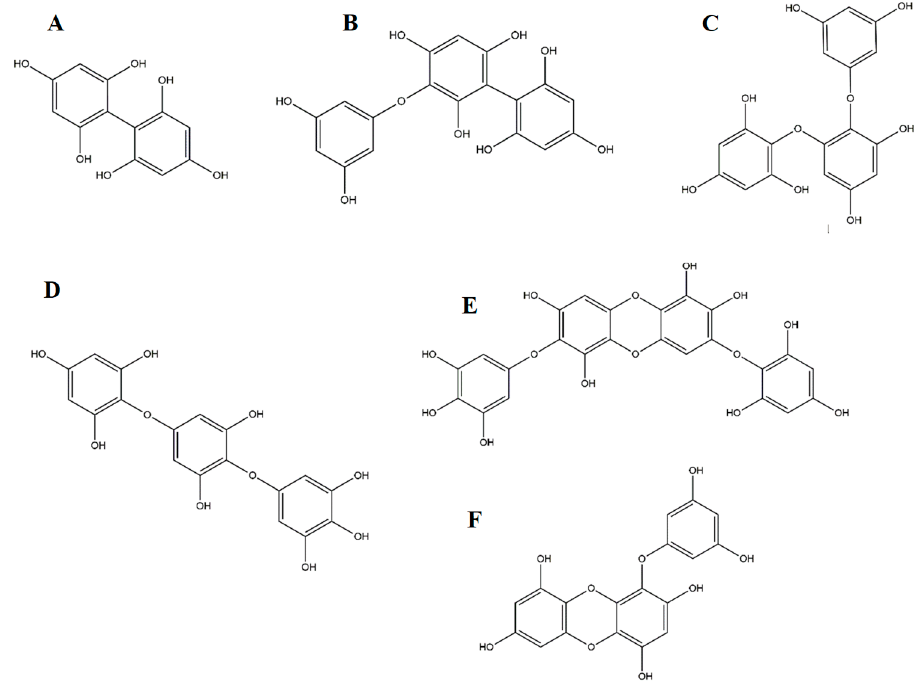
Figure 2. Some representative phlorotannins from brown seaweeds: ( A ) Fucol; ( B ) Fucophlorethol; ( C ) Phlorethol; ( D ) Fuhalol; ( E ) Carmalol; ( F ) Eckol.